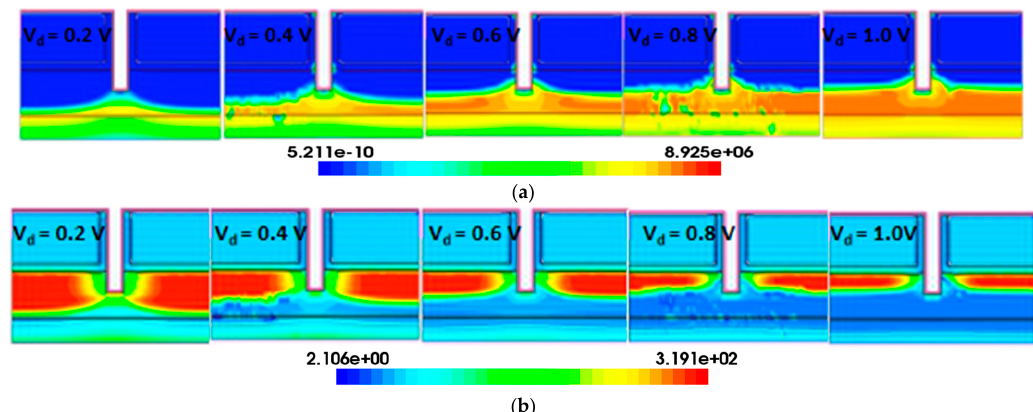
Figure 7. ( a ) Hole velocity and ( b ) hole density in the TGTFET after the ion strike (t = 5 ps). LET = 1000 MeV ∙ cm 2 /mg. V d = 0.2, 0.4, 0.6, 0.8, and 1 V.